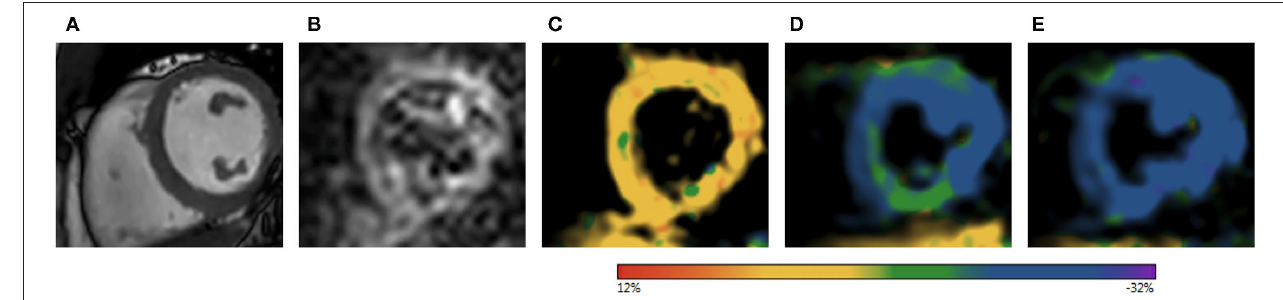
FIGURE 2 | Example of the image acquisition and GLS response of a healthy volunteer as visualized in the MyoStrain ® software. (A) Cine sequence of a midventricular short axis slice. (B) fSENC-images of midventricular short axis slice at end-diastole. (C–E) Corresponding color-coded images after post-processing at end-diastole (C) , end-systole at rest (D) , and after 2min of DHE (E) . As demonstrated in (D,E) , peak systolic longitudinal strain increased after DHE (color scale represents regional longitudinal strain). GLS, global longitudinal strain; fSENC, fast strain-encoded magnetic resonance imaging; DHE, dynamic handgrip